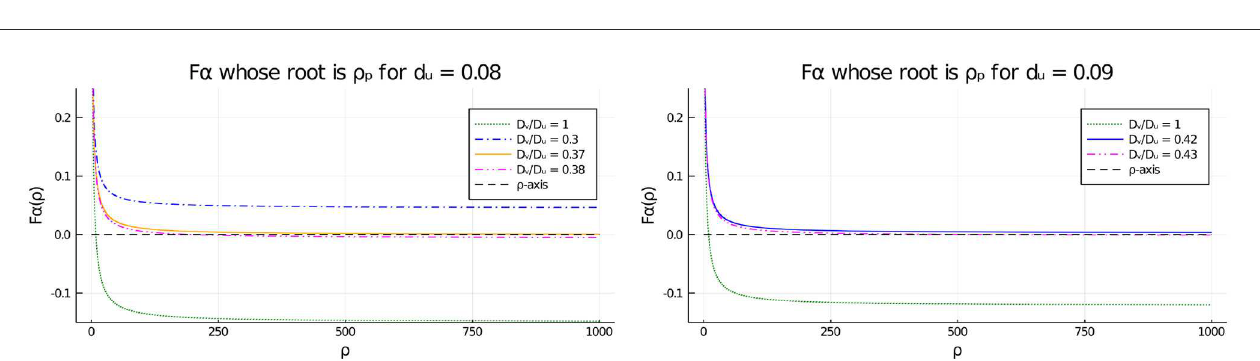
FIGURE11 Effect of the diffusivity ratio D v / D u on the existence of the pitchfork point when d u the asymptote of F α ( ρ )